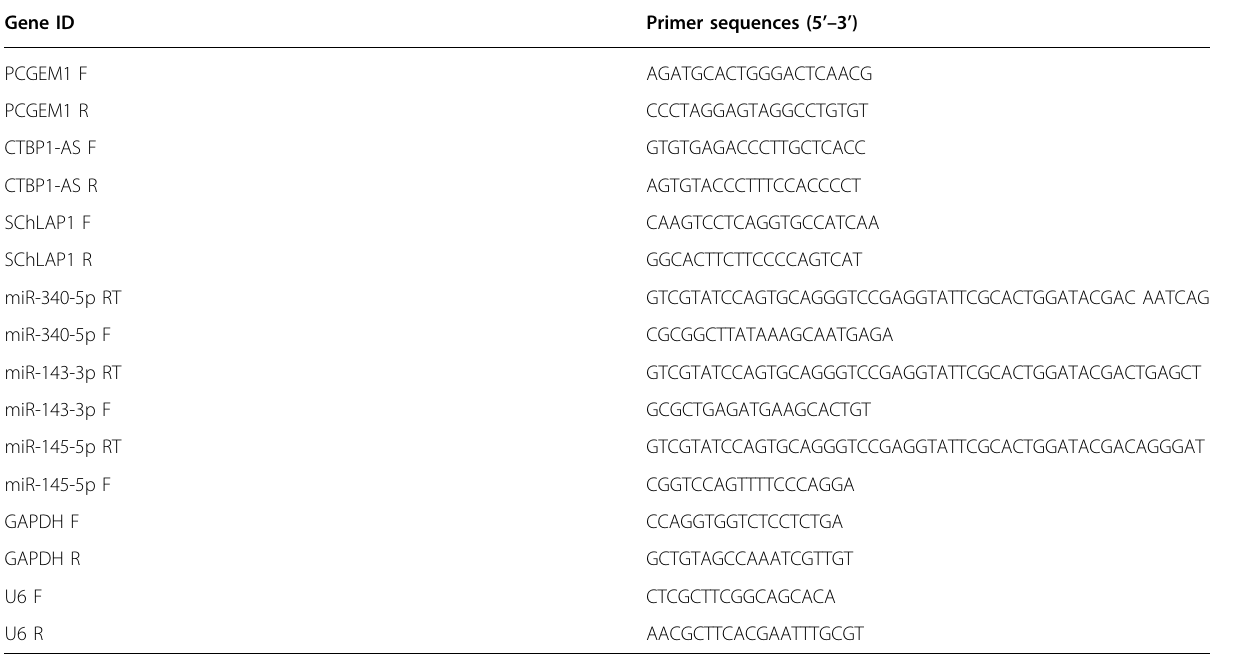
Table 1 Primer sequences used for quantitative PCR assay. Gene ID Primer sequences (5 ’– 3 ’